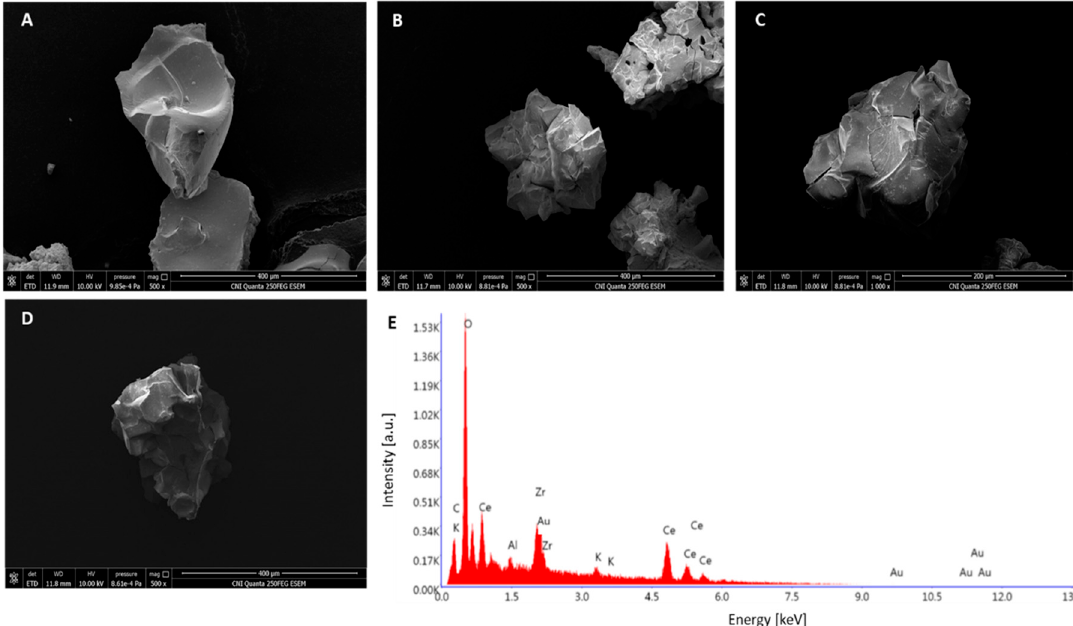
Figure 2. SEM-EDX results: Images of the gold containing catalysts without ( A ) and with potassium: 0.3 ( B ) and 0.6 at% ( C ), and the support with 0.3 at% potassium ions ( D ), as well as the EDX results for Au + 0.6 at% K / Ce 0.85 Zr 0.15 O 2 . Table 2. Results of X-ray Photoelectron Spectroscopy